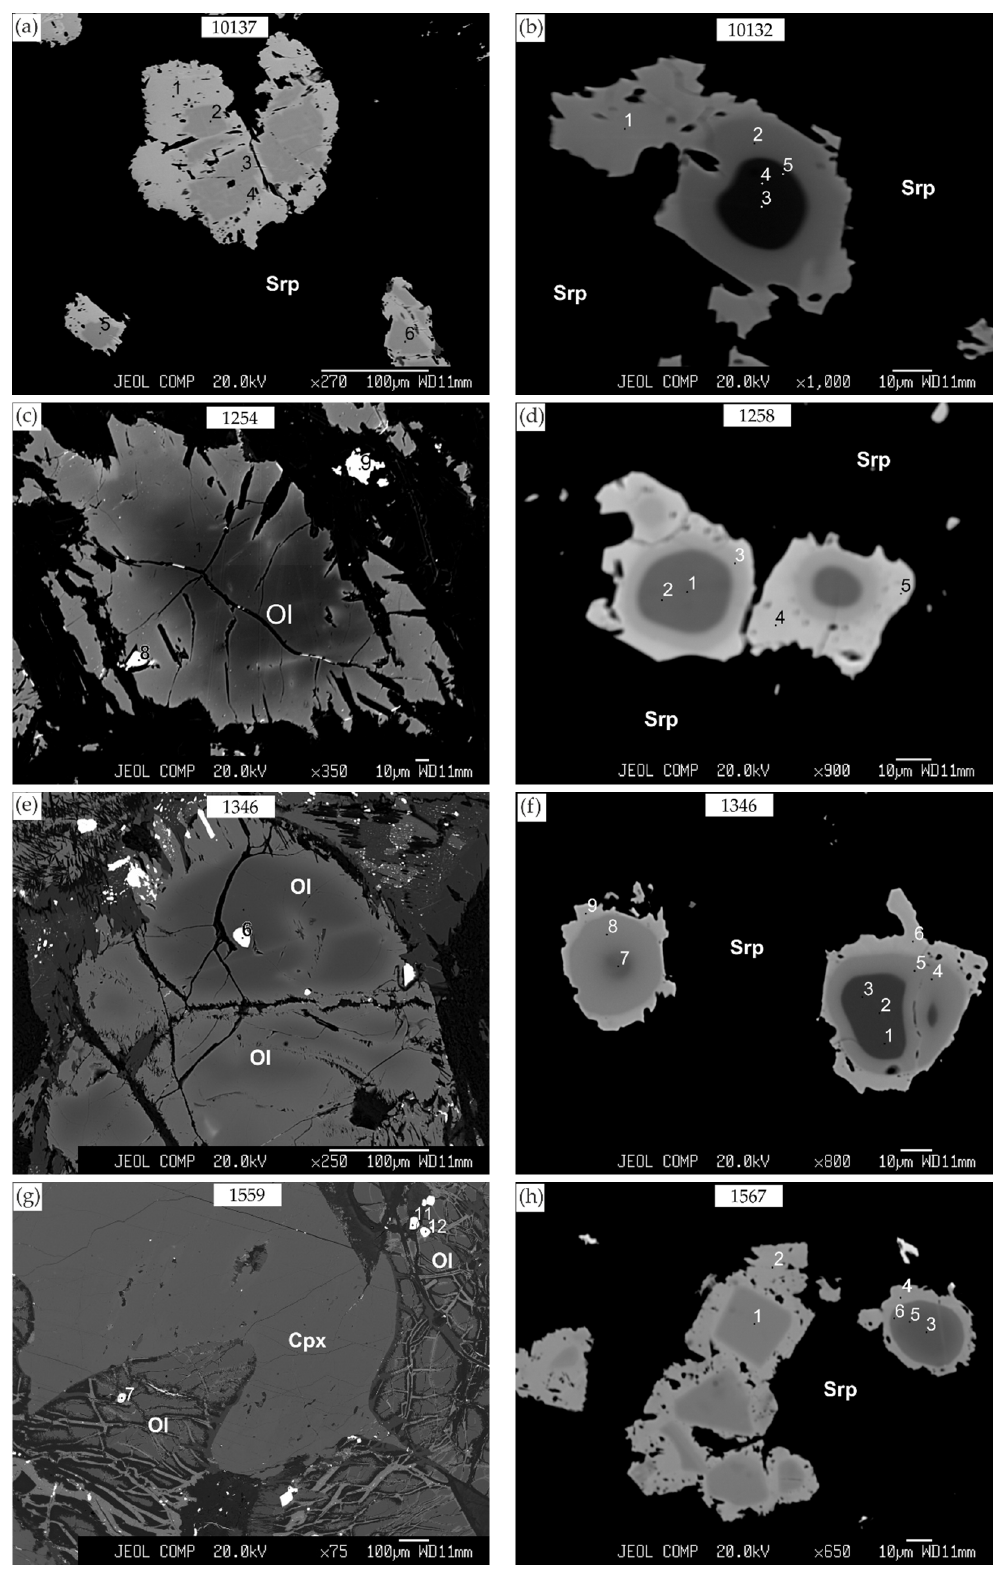
Figure 5. Back-scattered electron image of Cr-spinel from: ( a,b ) the Moryany intrusion; ( c,d ) The Ulan-Khan intrusion; ( e,f ) The Zunduk intrusion; ( g,h ) The Onguren intrusion. Ol: olivine; Cpx: clinopyroxene; Srp: serpentine. The points correspond to the analyses shown in Tables S3–S6.